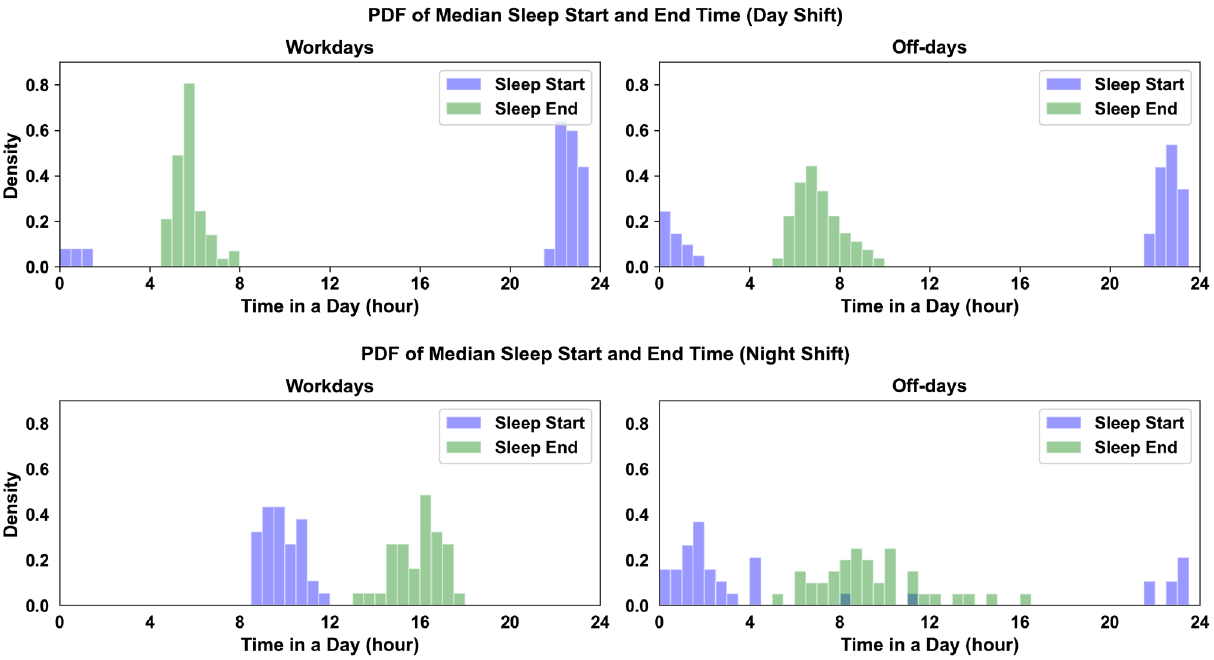
Figure 3. The figure exhibited the distribution of median sleep onset time and median wake-up between day shift nurses (top) and night shift nurses (bottom) at workdays and free days. x axis presents the time in a on off-days than night shift group ( µ = 21.3% , σ = 1.2% ). Lastly, the effect of shift ( F ( 1, 91 ) = 4.50, p = 0.037 ) and age ( F ( 1, 91 ) = 9.76, p = 0.002 ) are significant on vigorous activity duration on off-days but the gender ( F ( 1, 91 ) = 0.46, p = 0.498 ) is not. Main effect analyses show that the day shift group has an average of 2.9 min more rigorous activity than the night shift group on off-days. In sum, our ecological sensing method quantifies that day shift nurses have 3.7% and 4.0% higher walk activity ratio than night shift nurses, and day shift nurses have 2.2 min longer vigorous activity than night shift nurses. Diurnal patterns of the the rest-activity ratio and the walk-activity ratio on workdays and off-days between the day and night shift groups are shown in Fig. 2. From the two-way repeated ANOVA test, we observe a main effect of shift ( F ( 1, 102 ) = 7.18, p < 0.01 ), time within a day ( F ( 5, 510 ) = 74.82, p < 0.01 ), and shift by time interaction ( F ( 5, 510 ) = 6.79, p < 0.01 ) for the rest-activity ratio on workdays. Pairwise comparisons with Fisher’s Least Significant Difference test reveal that the night shift group has a higher rest-activity ratio during 7–19 h ( p < 0.05 ) and a lower rest-activity ratio during 23–7 h on workdays than the day shift group ( p < 0.05 ). This difference might be impacted by their distinct working schedules. Similarly, the effect of shift, time within a day, and their interaction were also significant for the rest-activity ratio on off-days. Particularly, night shift nurses consistently have higher rest-activity ratio during 7–19 h on off-days ( p < 0.05 ), which suggests potential circadian misalignment among night shift nurses. Moreover, a two-way repeated ANOVA test reveals a main effect of shift ( F ( 1, 102 ) = 1.17, p < 0.01 ), time within a day ( F ( 5, 510 ) = 178.45, p < 0.01 ), and shift-by-time interaction ( F ( 5, 510 ) = 24.64, p < 0.01 ) for the walk activity ratio on workdays. Post-hoc analysis shows that the day shift group has more walk activity during 7–19 h ( p < 0.05 ) and less walk activity during 19–7 h ( p < 0.05 ). Lastly, day shift group also has a higher walk activity ratio on off-days during 7–19 h ( p < 0.05 ), with the largest difference ( 11.3% , p < 0.01 ) occurring within 7–11 h in a day. Physical activity, shift, and self‑report behavioral variables. Linear regression analyses in Table 3 shows that the walk activity ratio on off-days with the age, the gender, and the shift schedule can fit a reasonable R 2 score with SWLS ( F ( 5, 88 ) = 3.79, p < 0.01 , adj. R 2 = 0.131 ), PSQI ( F ( 5, 88 ) = 4.54, p < 0.01 , adj. R 2 = 0.160 ), and PA ( F ( 5, 89 ) = 3.36, p < 0.01 , adj. R 2 = 0.112 ). The shift [Day shift] × Rest-activity ratio (off-day) is sig- nificant for predicting PA ( β = 0.57, t ( 89 ) = 2.16, p = 0.033 ). Moreover, the model including the walk activity ratio (off-day) can predict SWLS ( F ( 5, 88 ) = 4.07, p < 0.01 , Adj. R 2 = 0.142 ) with a reasonable R 2 score. The day shift group by walk-activity ratio on off-days has negative effect on SWLS ( β = − 0.62, t ( 88 ) = − 3.06, p < 0.01 ). Lastly, linear regression analyses (see supplementary) reveal that neither the walk activity ratio on workdays nor its interaction with shift schedule are significant for any self-report behavioral variables. Sleep pattern analyses. The three-way ANOVA test shows a main effect of the shift ( F ( 1, 90 ) = 65.55, p < 0.01 ) on sleep duration on workdays, but not the age ( F ( 1, 90 ) = 0.67, p = 0.415 ). The factor gender ( F ( 1, 90 ) = 4.79, p = 0.031 ) is also significant for the sleep duration on workdays. The estimated marginal means are 410.4 ± 7.1 min and 330.4 ± 8.4 min for night shift participants and day shift participants, respectively (see Table 4). The effect of the shift ( F ( 1, 90 ) = 2.65, p = 0.107 ) and the gen-